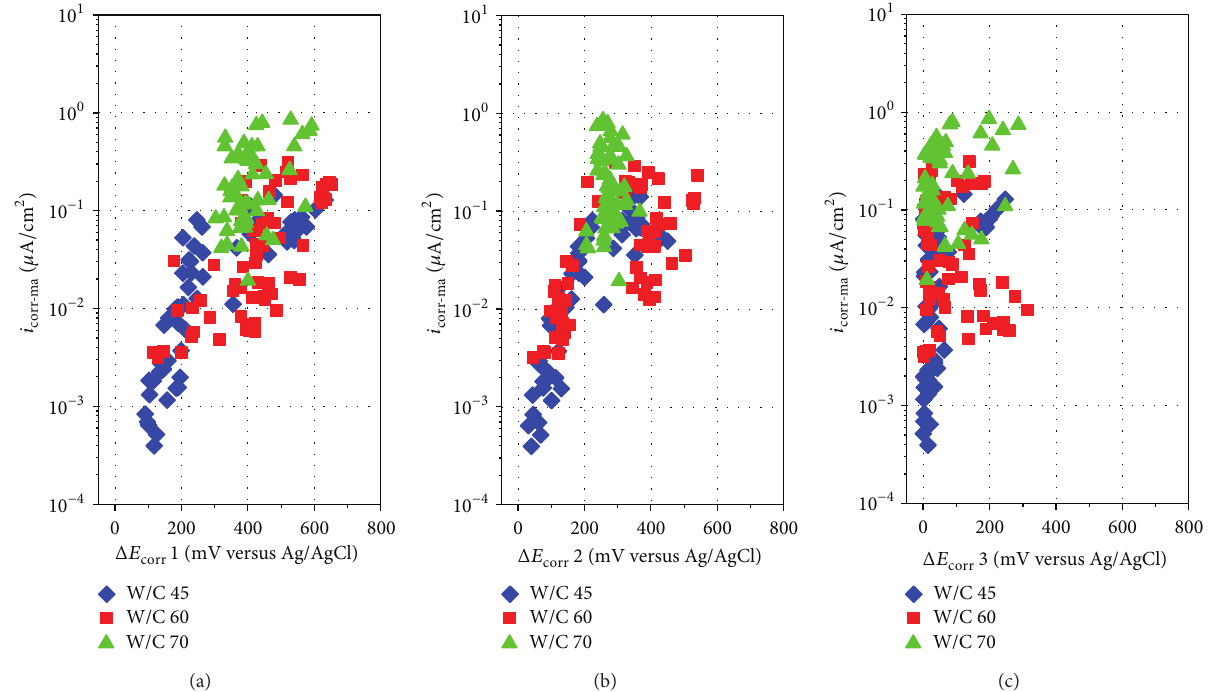
Figure 7: Effect of water-cement ratio on the (a) relationships between Δ𝐸 Δ𝐸 2 and macrocell current density, and (c) relationships between Δ𝐸 corr